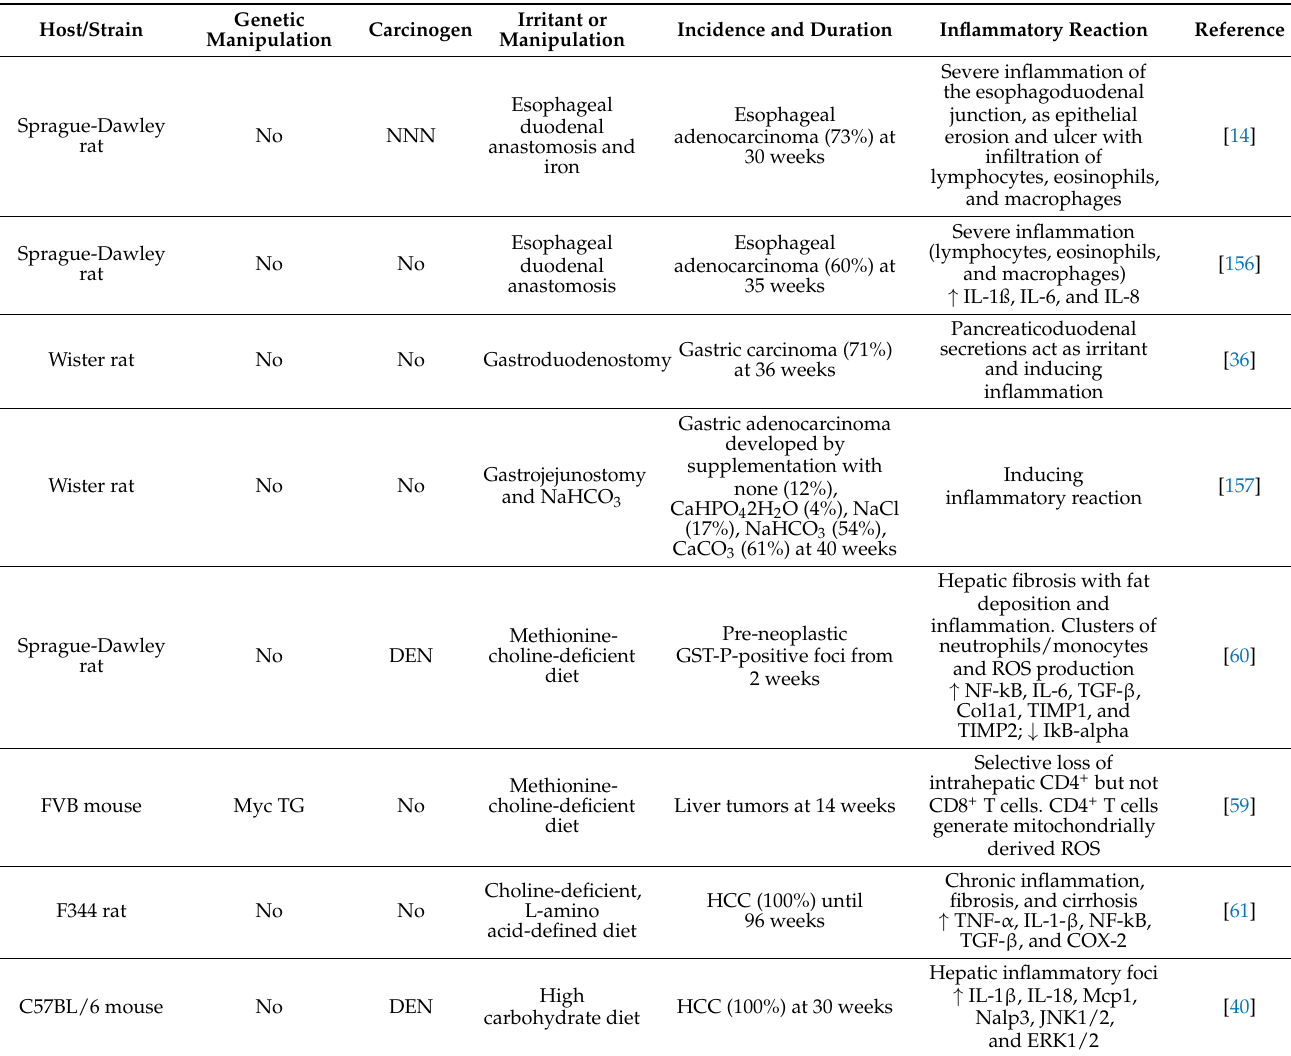
Table 2. Surgery, hormone, or diet-induced inflammation-related carcinogenesis